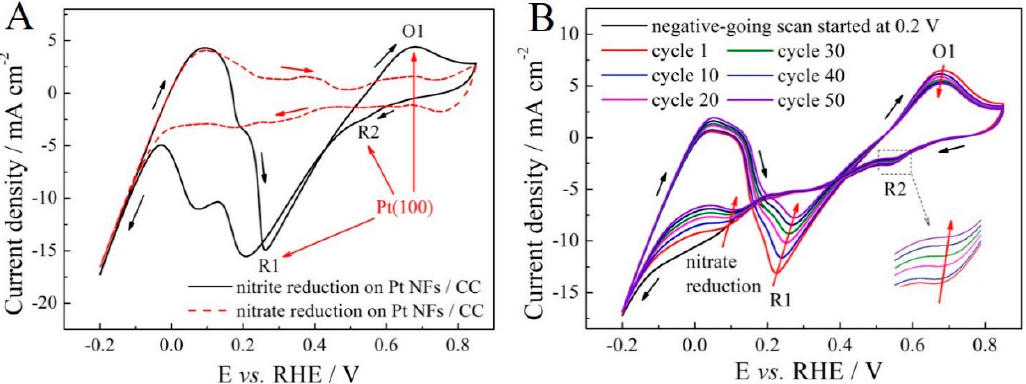
Figure 4. CVs of Pt NFs / CC ( A ) in 0.1 M NaOH containing 20 mM NO 2 − (solid line) and 20 mM NO 3 − (dash line); CVs of Cu / Pt NFs / CC ( B ) in 0.1 M NaOH containing 20 mM NO 3 − . Scan rate is 20 mV s − 1 .